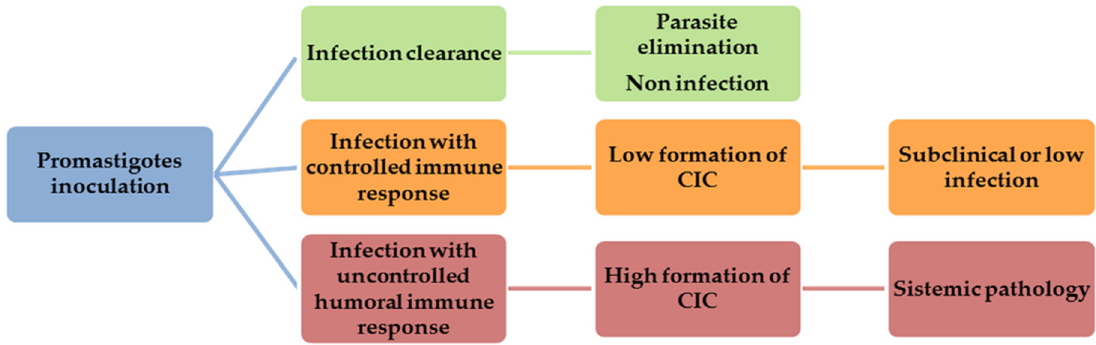
Figure 1. Canine visceral leishmaniasis (CanL) development after promastigotes inoculation.